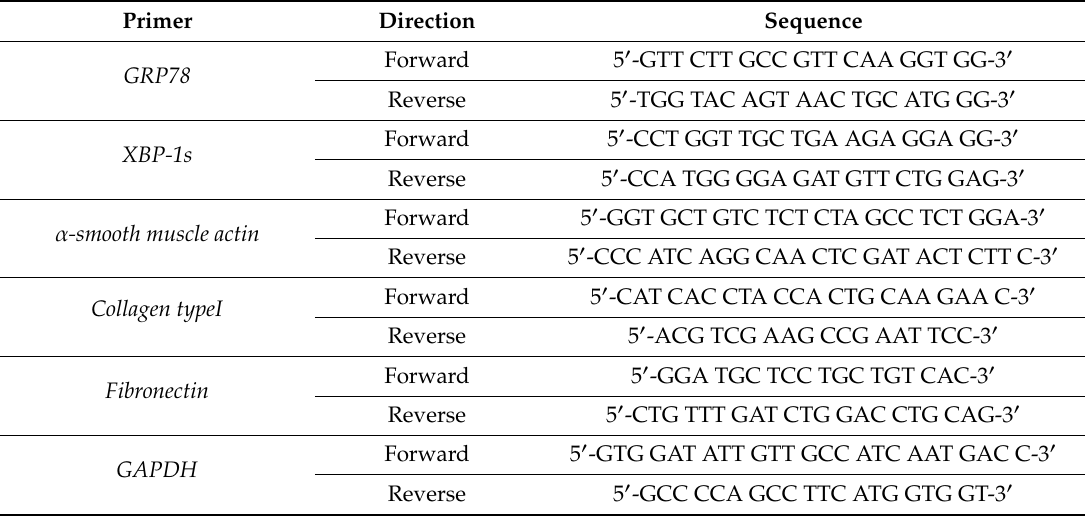
Table 1. Sequences of primers used for real-time